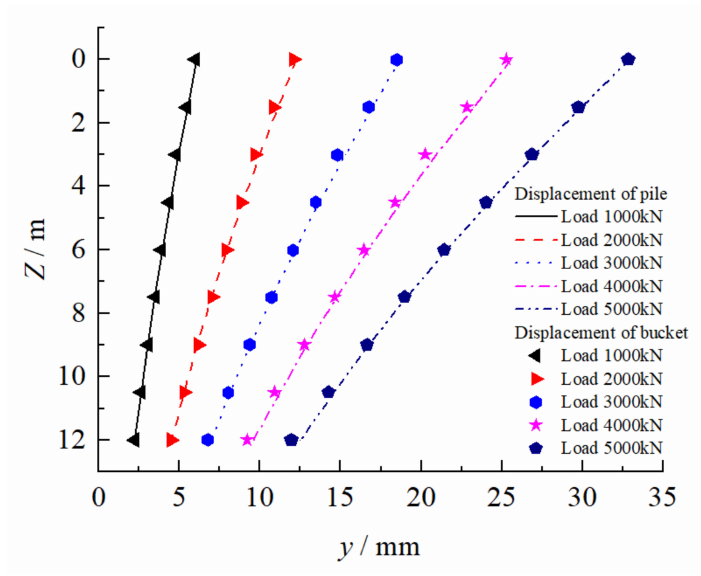
Figure 9. Lateral displacement distribution of bucket-reinforced part.